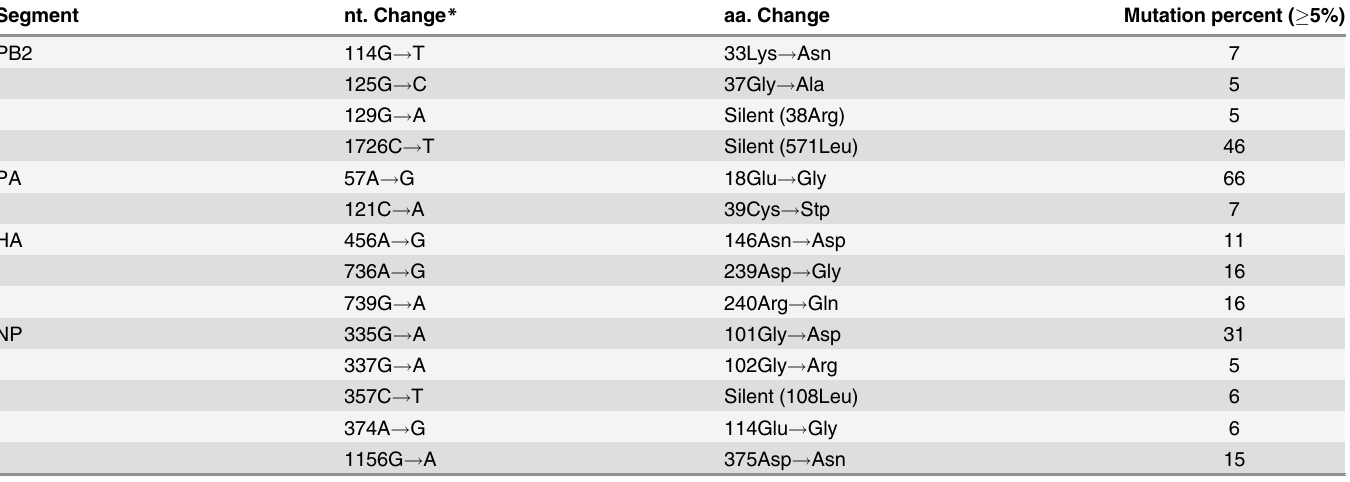
Table 4. HiSeq sequencing of RNA Library prepared from A/Ca/07/2009 (H1N1) virus. Note: These mutation percentages were calculated per compari- son of A/California/07/2009 (H1N1) genome with its published sequence. (See accession numbers in Materials and Methods paragraph.) aa: Amino acid, nt: Nucleotide.